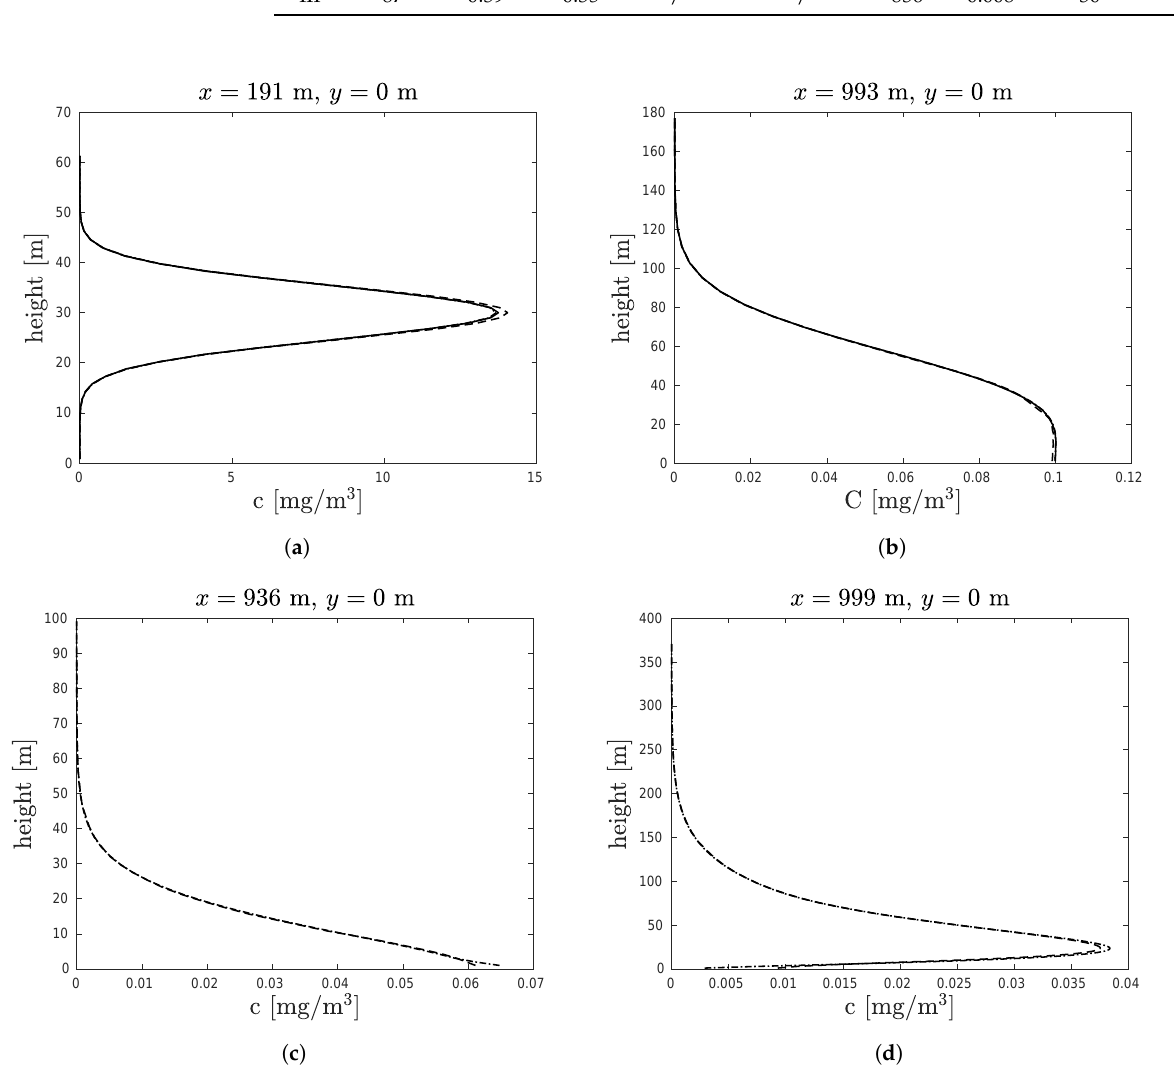
Figure 1. Concentration predictions due to an instantaneous point release by the PI ( − .) and KS ( − − ) estimator ( n p = 10 8 particles). Case I–HT ( a ) 20s after release, ( b ) 104s after release, exact solution (39) ( − ) also displayed. ( c ) Case I, 120s after release. ( d ) Case III, 118s after